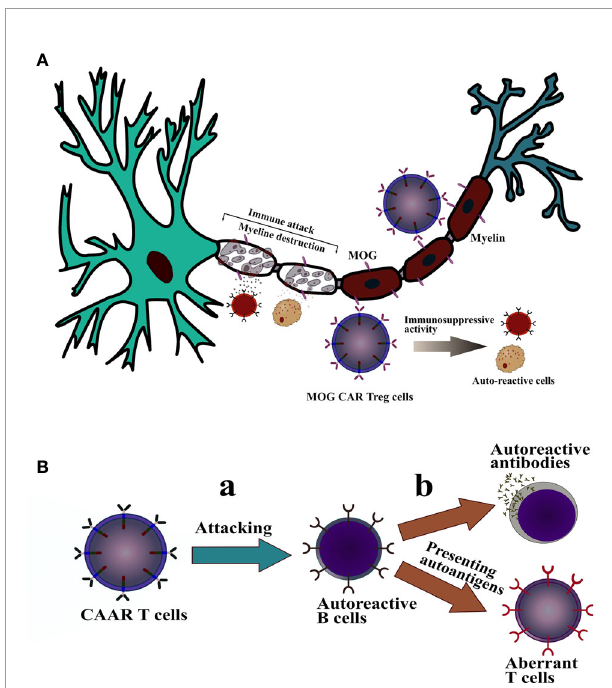
FIGURE 2 | The mechanism of action of CAAR-T cells and CAR-Treg cells against autoimmune disease. (A): MOG CAR-Treg cells effectively bind and is localized to the MOG + oligodendrocytes in CNS and exert their immunosuppressive manner to protect myelin against immune attack. (B) : (a); T cell expressing CAAR speci fi c for B cell receptors targets aberrant B cells. (b); further, it inhibits B cell development from secreting autoreactive antibodies and prevents B cells from presenting autoantigens to autoreactive T cells, which leads to suppression of T cell-mediated autoimmune